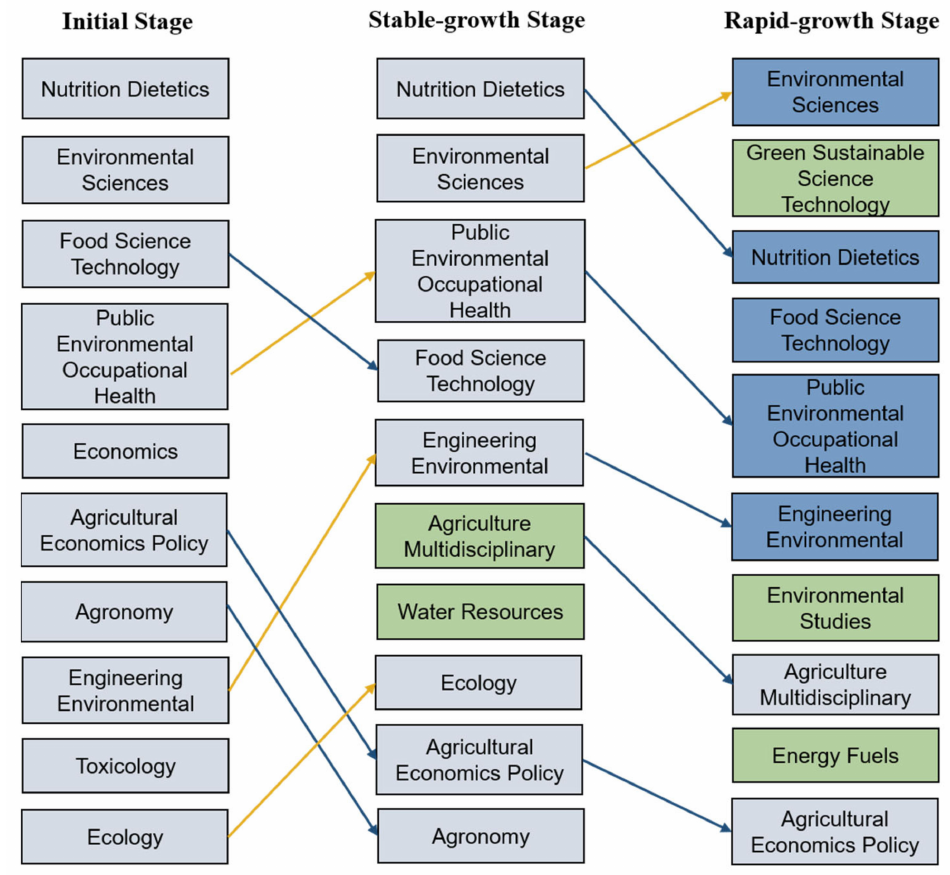
Figure 6. Evolution of WoS categories of UFS research over three